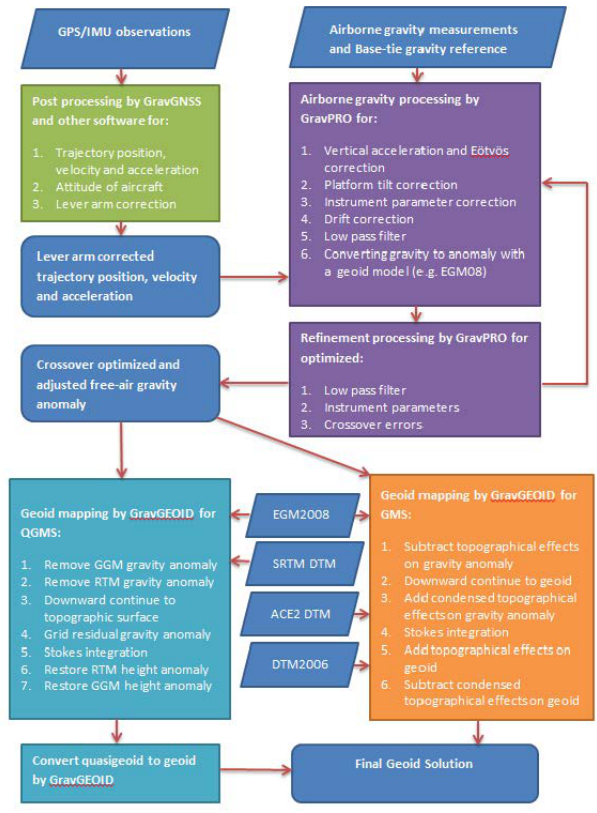
Figure 1: Overview of data processing steps for airborne gravity, geoid (GMS) and quasigeoid